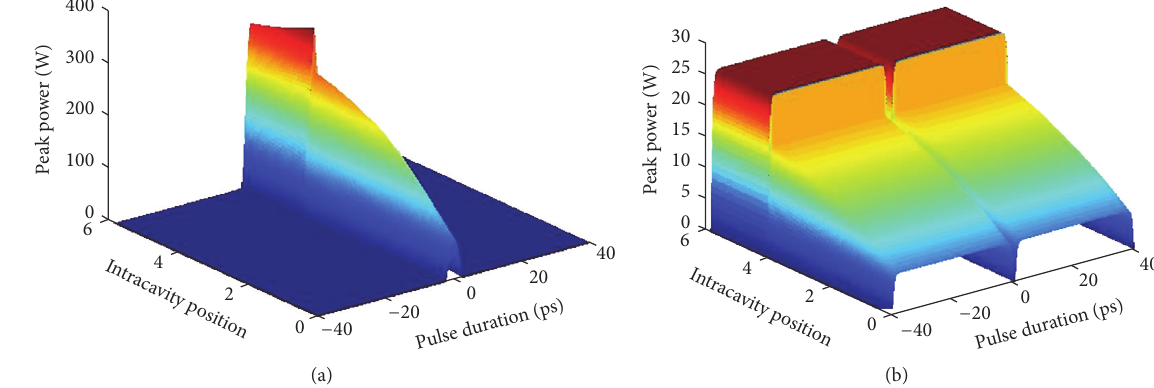
Figure 3: (a) Intracavity dissipative soliton evolution (at round = 498) in temporal domain. (b) Intracavity dark soliton evolution (at round = 498) in temporal domain.